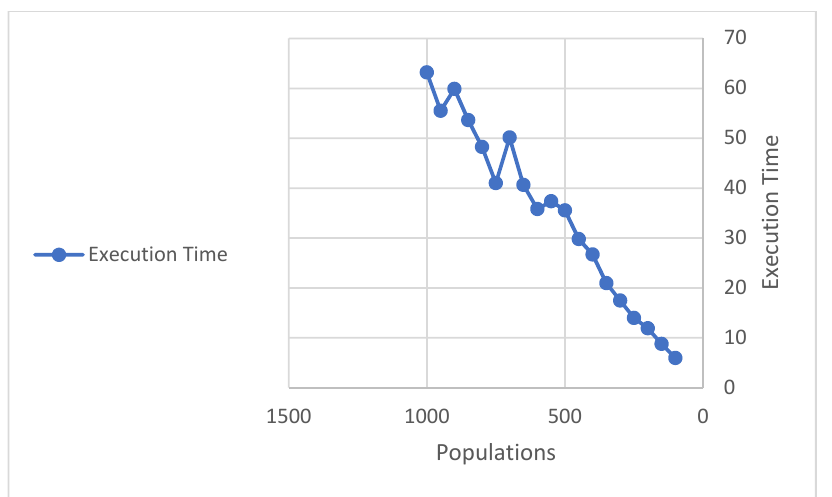
Figure A1. The execution time of the proposed model compared to state-of-the-art methods.